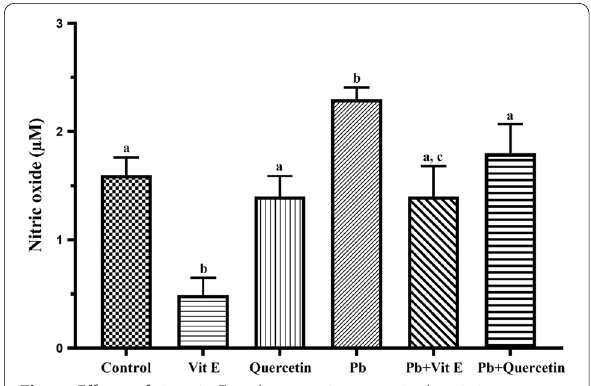
Fig. 1 Effects of vitamin E and quercetin on testicular nitric oxide level in lead acetate treated male Wistar rats. Bars represent mean SEM, means bearing different superscripts between groups ± differ significantly at p <